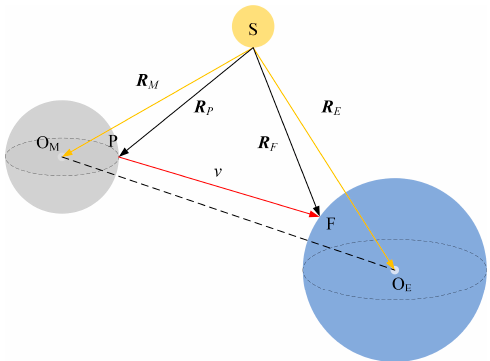
Figure 1. Geometric relationship between the Earth’s surface features and a Moon-based platform. Not drawn to